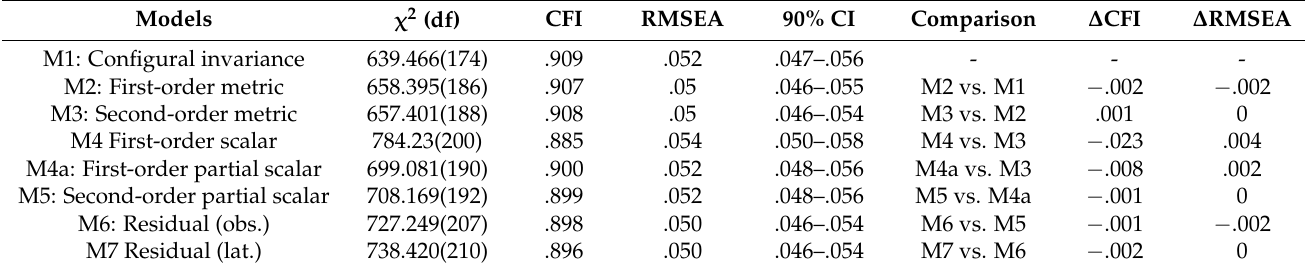
Table 6. Measurement invariance across gender.